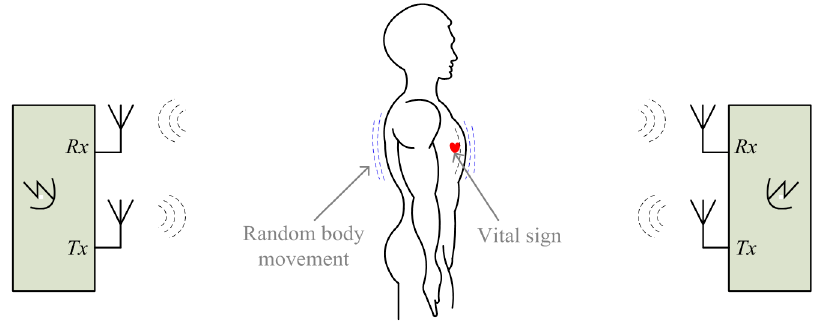
Figure 6. Setup of noncontact vital sign detection using two radars with random body movement cancellation.